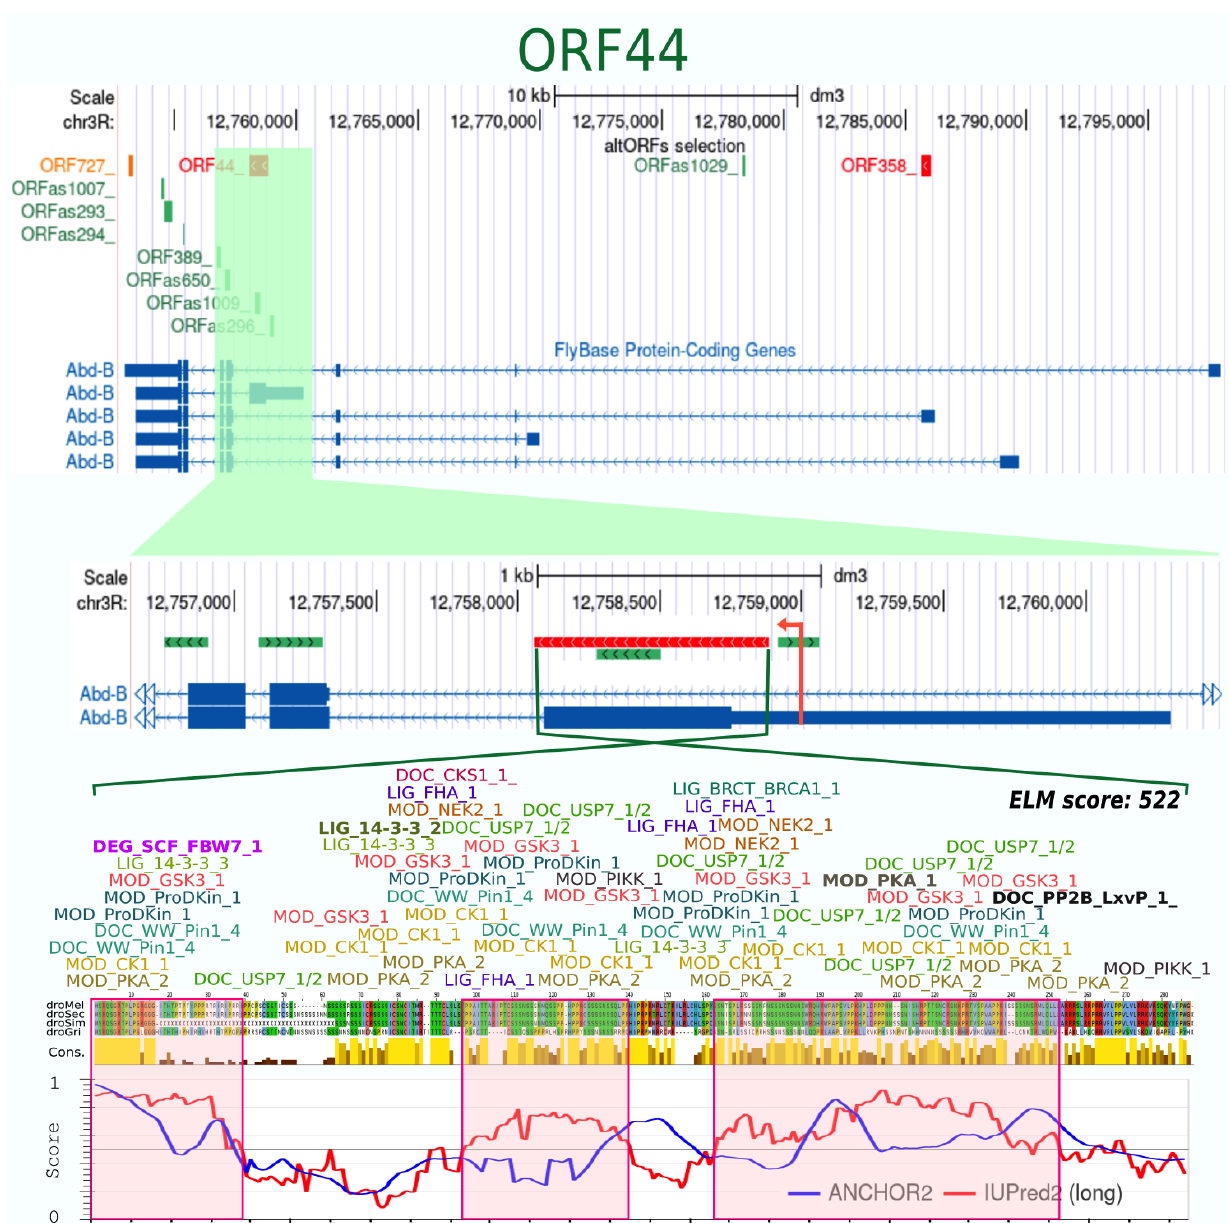
Figure 4. Characterization of the ORF44. This altORF overlaps with the 5 (cid:48) UTR and first coding exon of one AbdB transcript. It is in the same orientation but in a different reading frame. This altORF was found in 4 Drosophila species. The 274 aas long predicted protein displays three disordered regions (highlighted in pink) and numerous ELMs of different